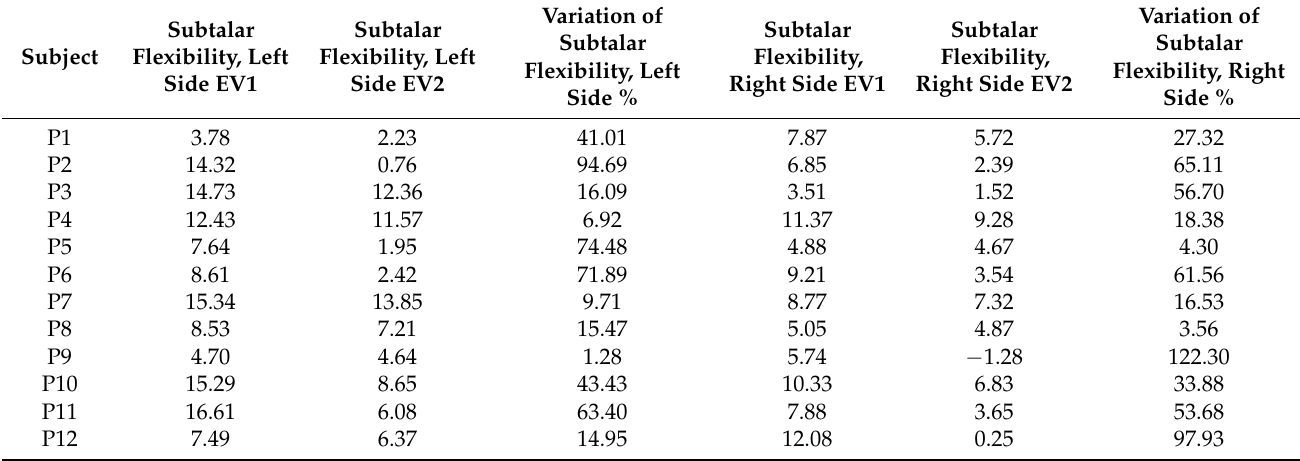
Table 3. Evolution of subtalar flexibility (Group 2, n = 15).